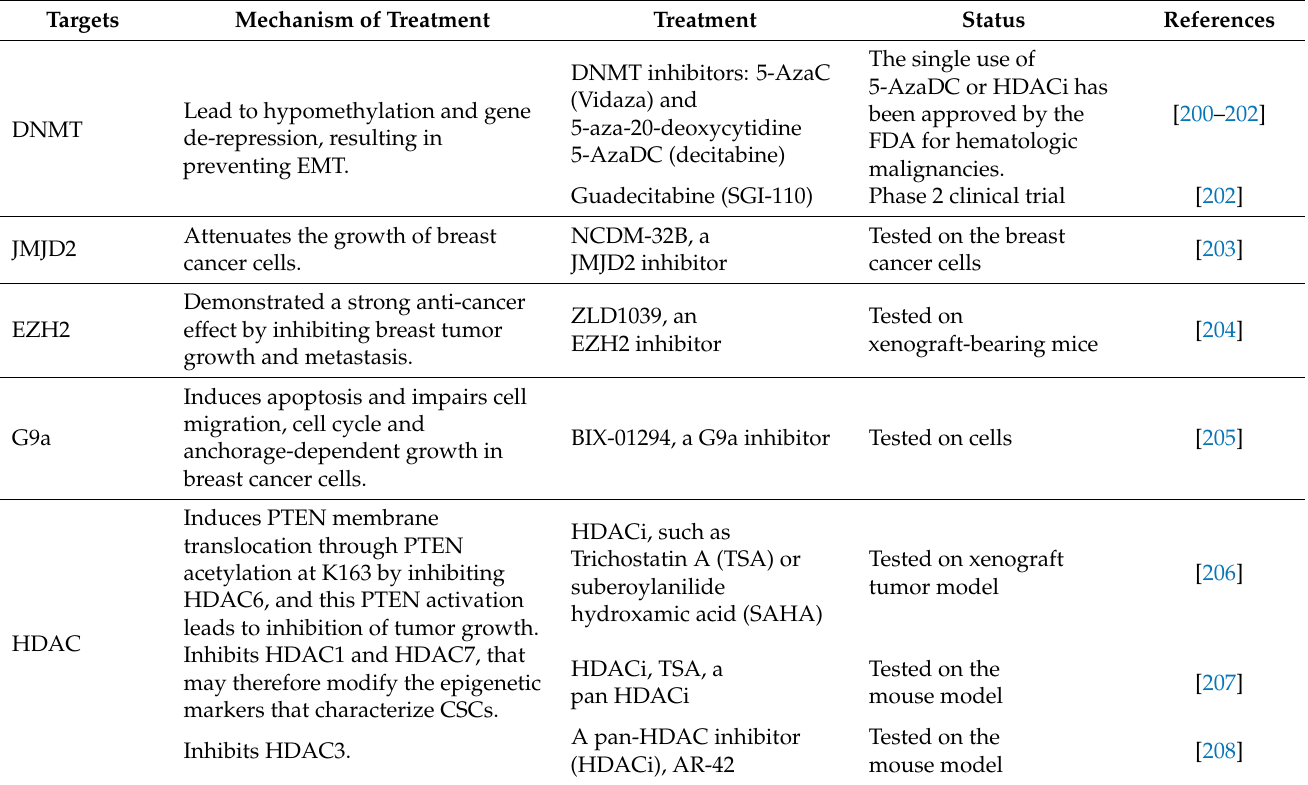
Table 2. The therapeutic implications targeting epigenetic regulation for breast